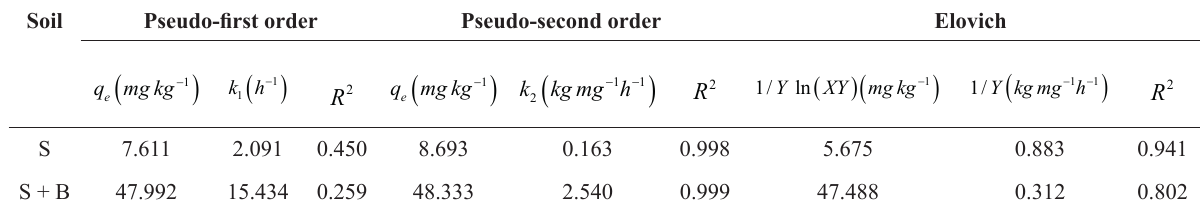
Parameters obtained in the sorption kinetics of CMZ in soils amended (S + B) and without the addition of biochar (S). Soil